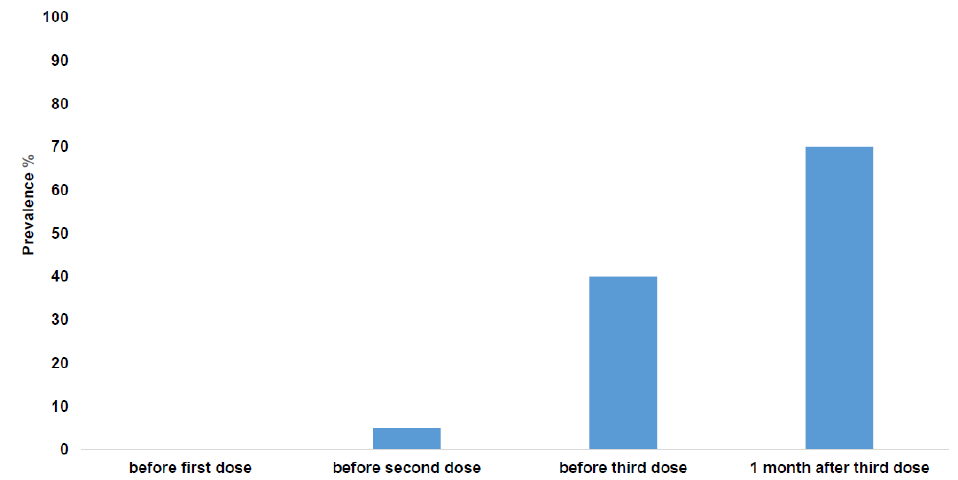
Figure 3. Prevalence of anti-SARS-CoV-2 antibodies after different doses of the mRNABNT162b2 vaccine. In a different study, Kamar et al. [33] documented the efficacy of three vaccine doses (BNT162b2) in 850 SOT recipients. The study evaluated the anti-SARS-CoV-2 spike protein and neutralizing antibodies at 1 and 3 months after three doses. The study reported that only two-thirds of SOT recipients developed antibodies, while one-third remained unprotected. This study highlights the importance of immune monitoring to optimize vaccination in SOT